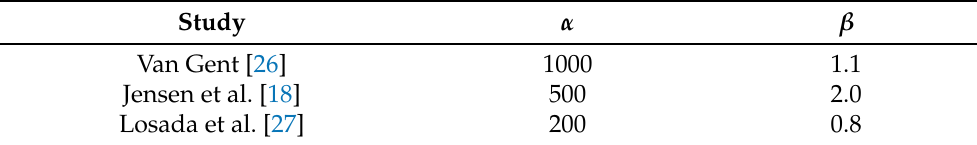
Table 2. Resistance coefficients α and β used in different